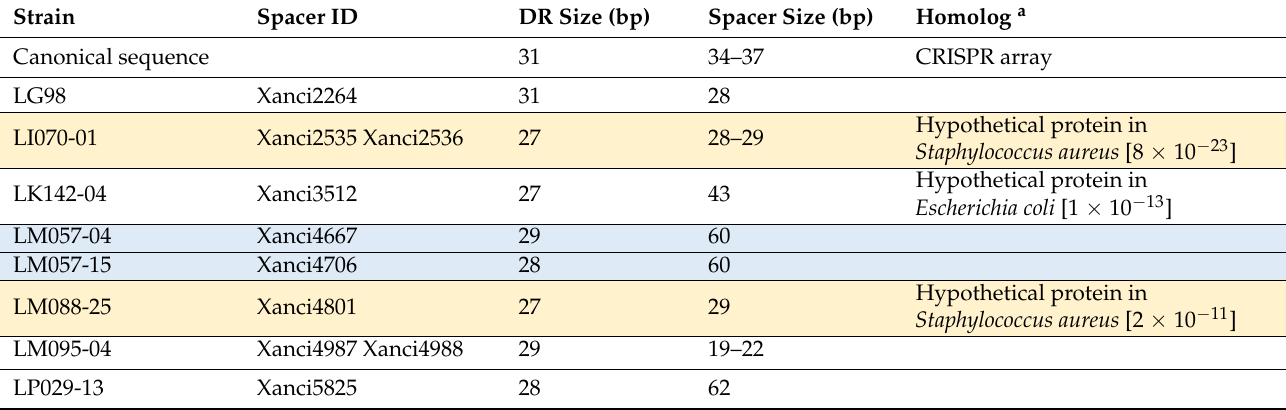
Table 2. Predicted false positive CRISPR arrays in X. citri pv. citri